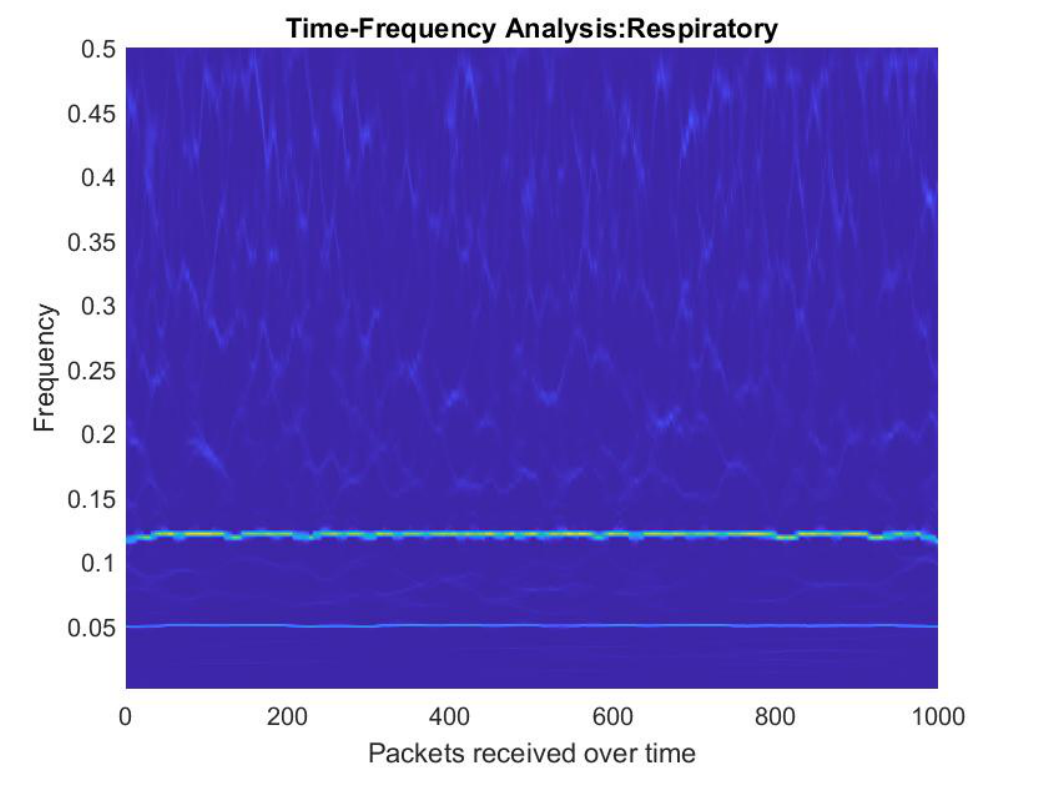
Figure 10. Time–frequency spectrogram for the respiratory